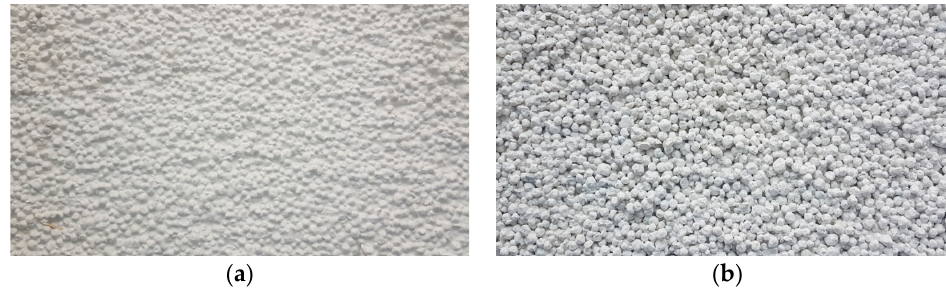
Figure 1. EPS – gypsum composites with ( a ) closed structure (CM production method) and ( b ) open structure (SD production method).